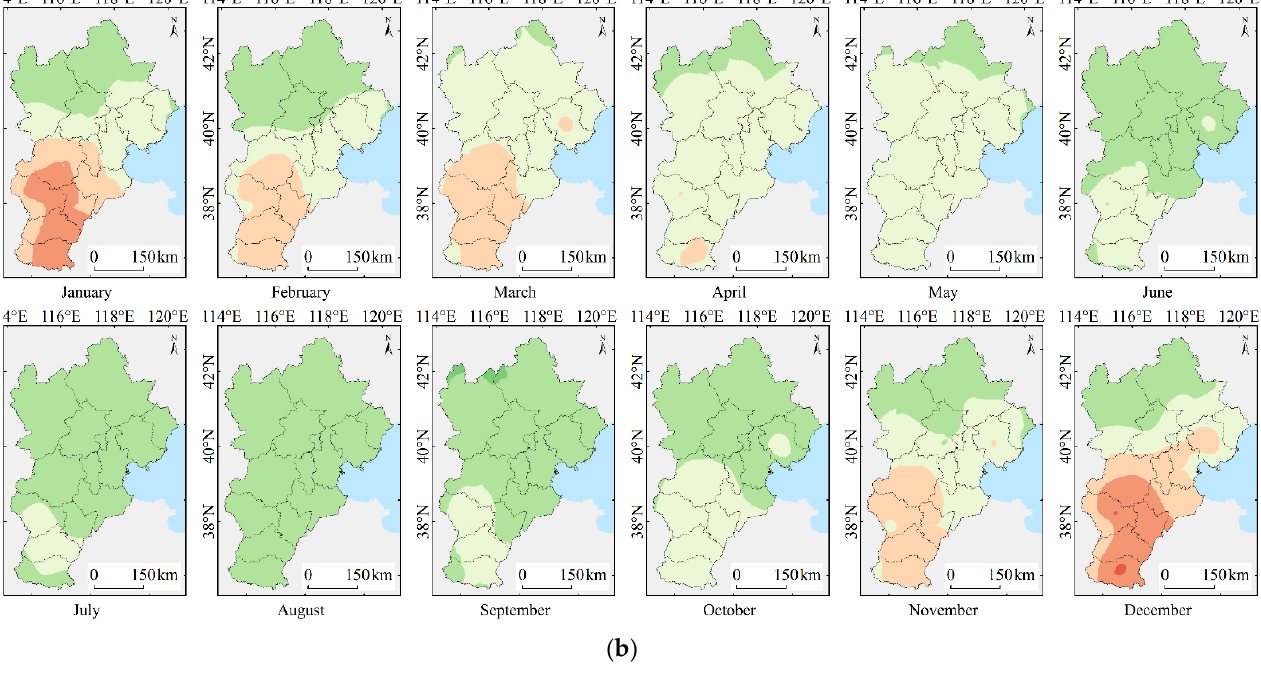
Figure 9. Spatial distribution of the monthly mean values of PM 2.5 ( a ) and PM 10 ( b ) concentrations.